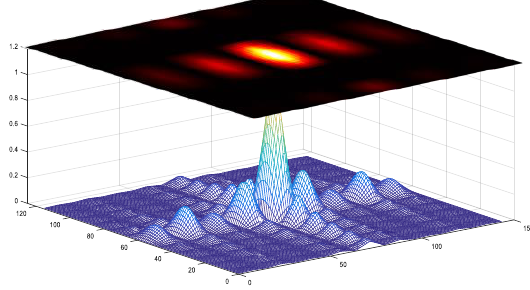
Figure 4. Cross-ambiguity function (CAF) envelope feature.